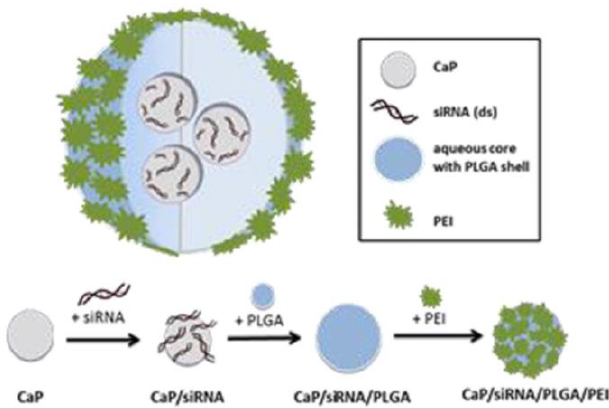
Figure 3. CaP-siRNA is an enema containing nanoparticles (~150 nm) of siRNA against TNF-α loaded on calcium phosphate (CaP), which is then encapsulated in poly(lactic– co -glycolic acid) (PLGA) coated with polyethylenimine (PEI). Reprinted from Frede et al. [137] with permission from Elsevier.